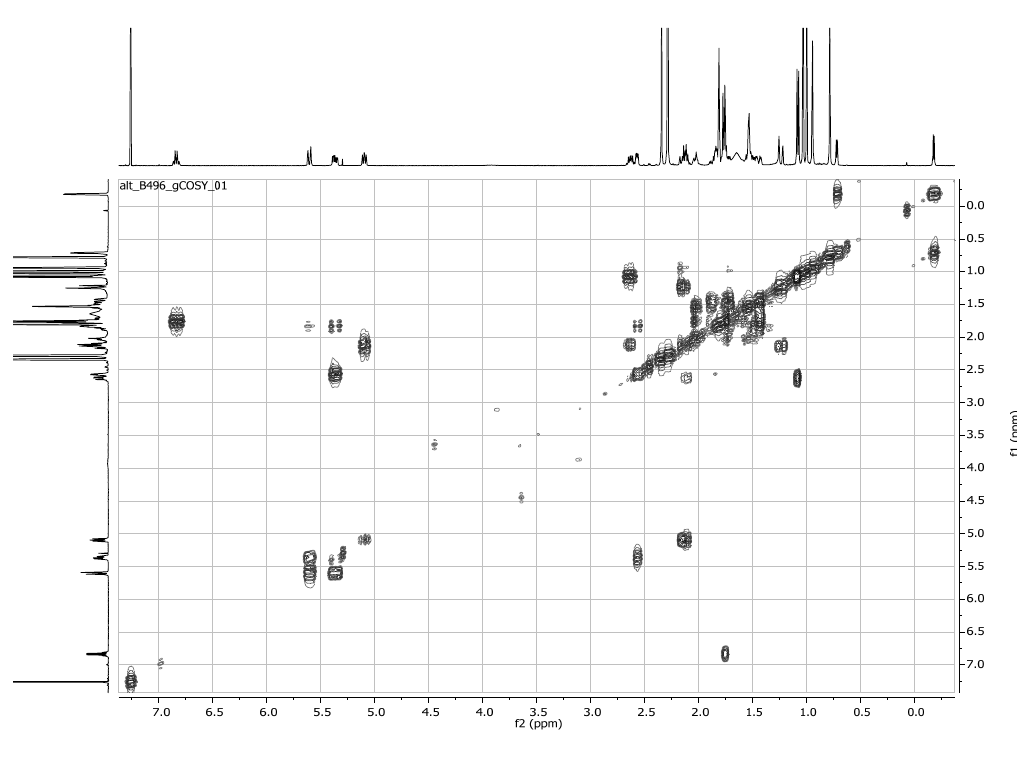
) of compound 1 . 3